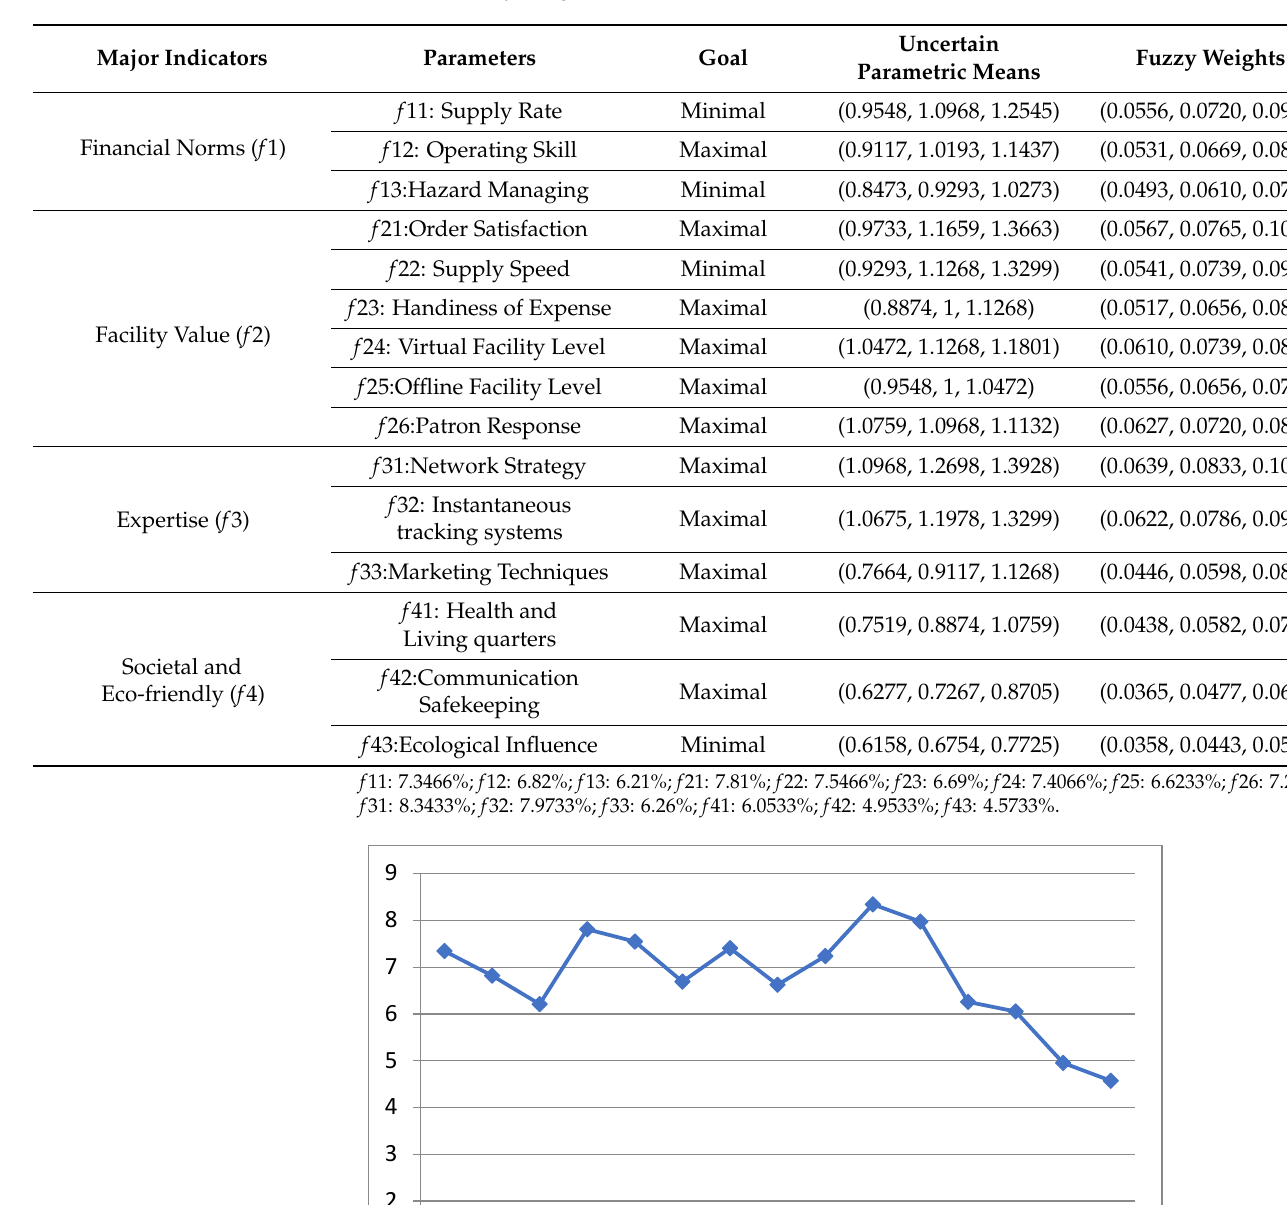
Table 11. Fuzzy weights for each criterion.